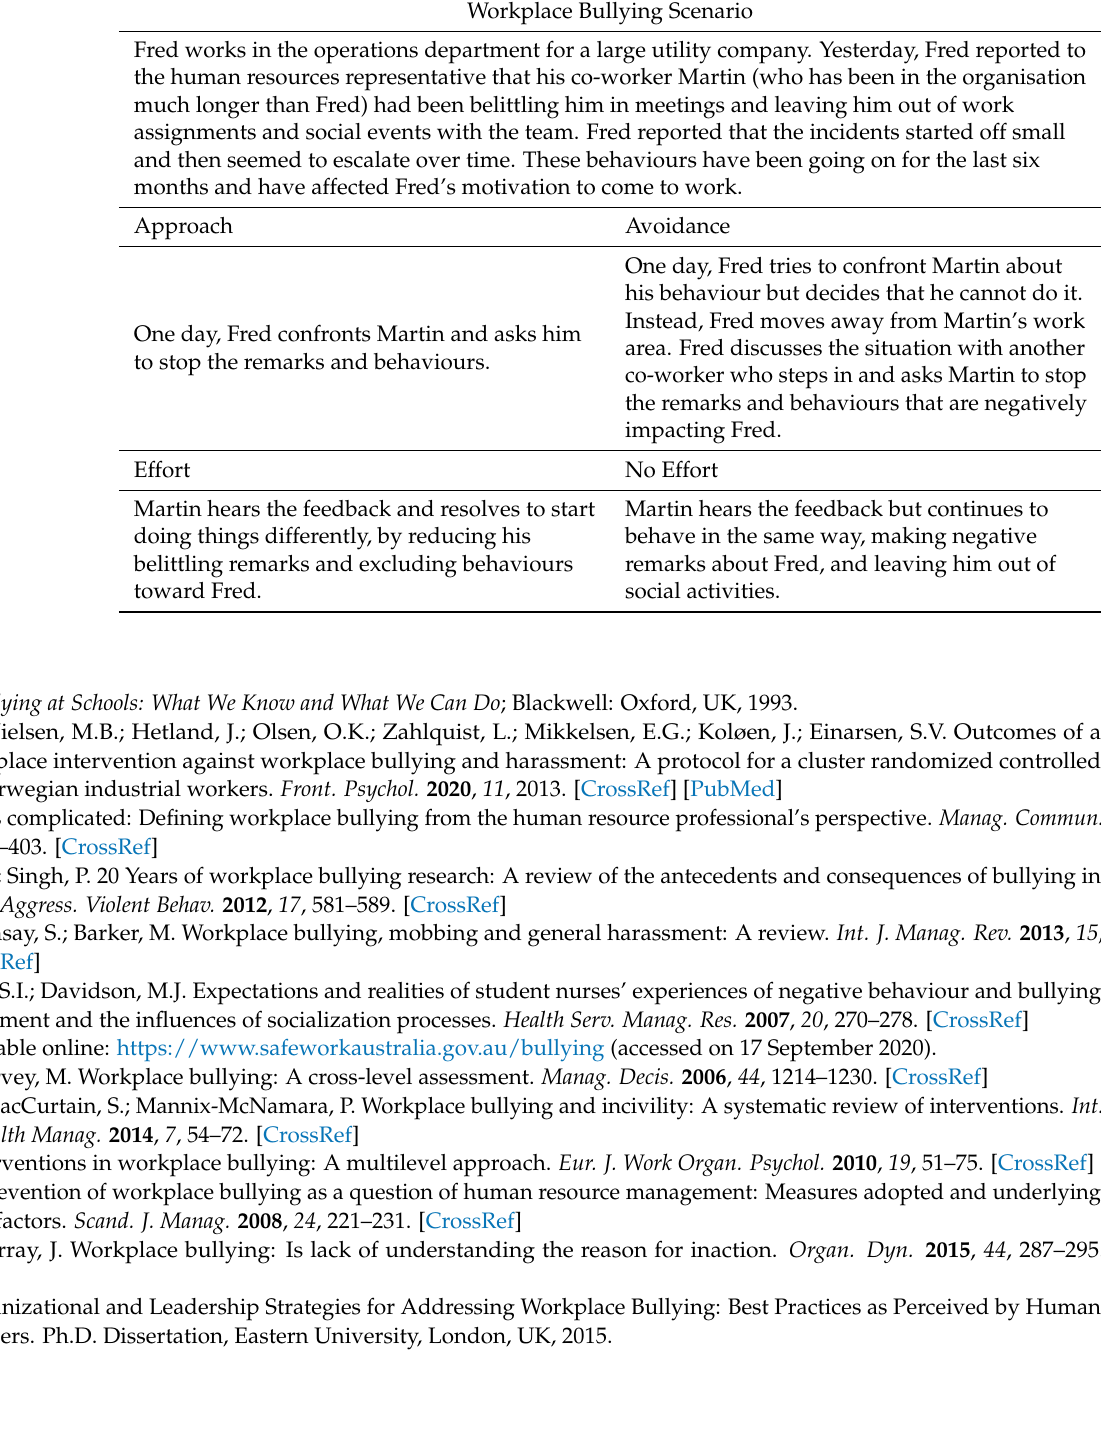
Table A1. Operationalisation of Coping Behaviours and Response Behaviours in the Experimen- tal